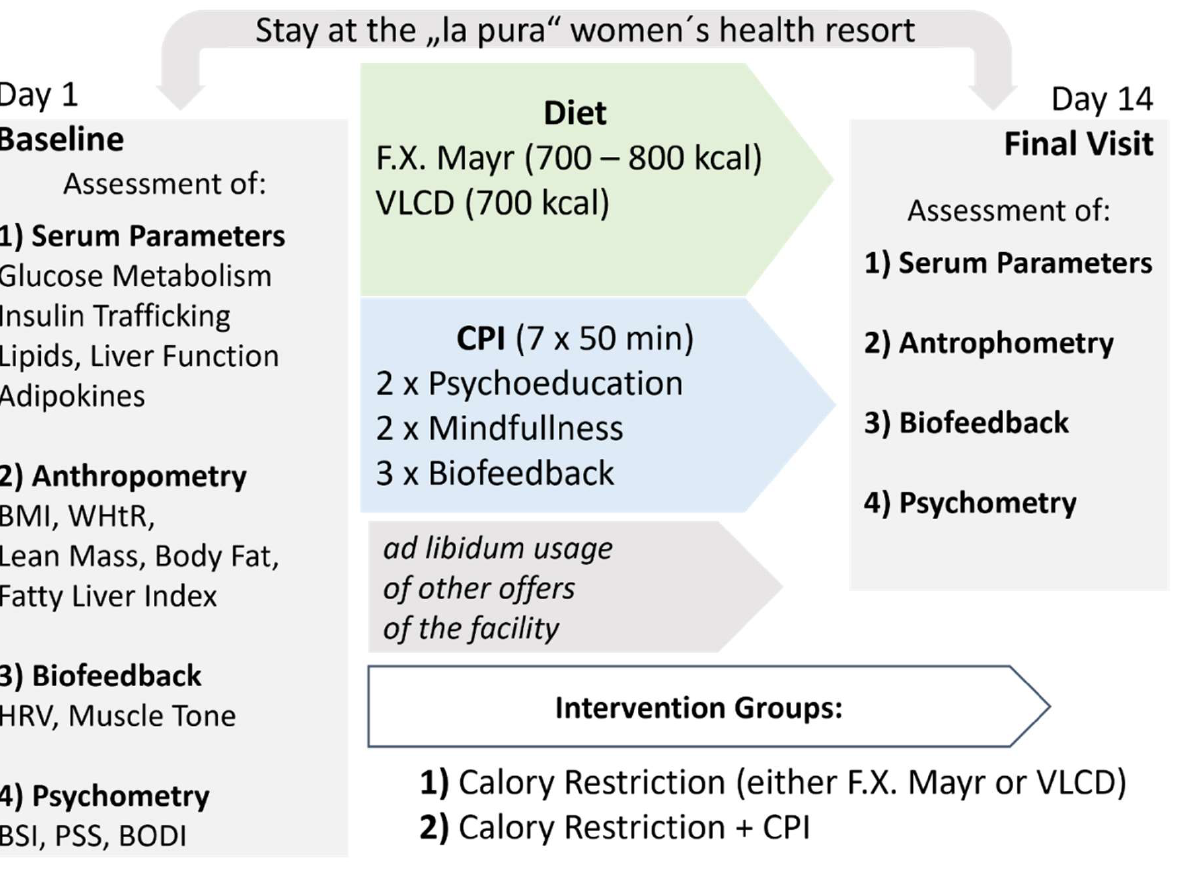
Figure 1. Timeline and rationale of the study design. Additional offers provided by the facility included sport programs, balneotherapy and massages, and were not restricted by the study protocol. Abbreviations: CPI = clinical-psychological intervention, VLCD = very-low-calorie diet, BMI = body mass index, BSI = brief symptom inventory, PSS = perceives stress scale, BODI = burnout dimensions inventory.